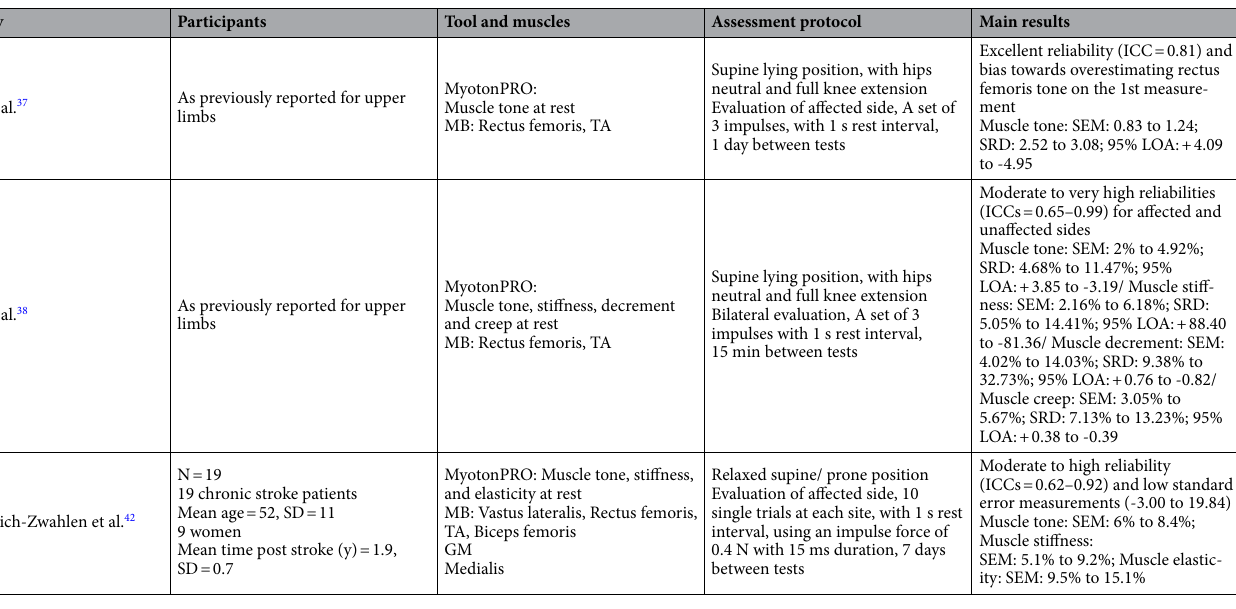
Table 4. Main characteristics of selected studies analyzing reliability of the myotonometry in the lower limbs. GM: gastrocnemius muscle; N: newton; MB: muscle belly; MDC: minimal detectable change; SRD: smallest real difference; TA: tibialis